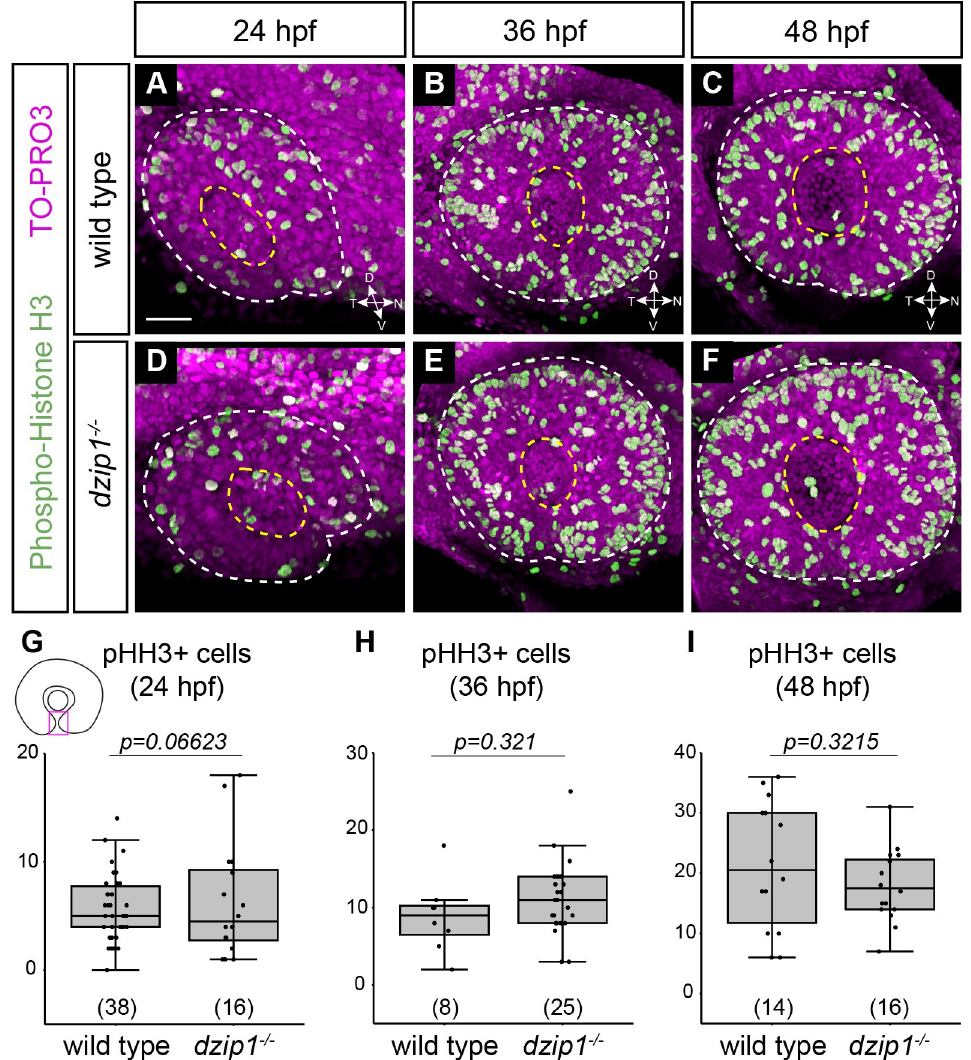
Fig 4. Cell proliferation in the optic fissure is not altered in the dzip1 mutant. (A-F) Whole mount immunofluorescence in wild type (A-C) and dzip1 ts294e mutants (D-F) for cell death ( green ; phospho-histone H3) and nuclei ( magenta ; TO-PRO-3) at 24 hpf (A, D), 36 hpf (B, E), and 48 hpf (C, F). All images are lateral views of 3-dimensional renderings. White dashed lines mark the boundary of the eye; yellow dashed lines mark the lens. (G-I) Quantification of total number of phospho-histone H3-positive cells within the optic fissure in the eye at 24 hpf, 36 hpf, and 48 hpf. n (embryos) for each genotype shown at the base of the graph. P -values were calculated using Welch’s t-test (M-O). Scale bar: 50 μ m. D, dorsal; V, ventral; N, nasal; T, temporal.